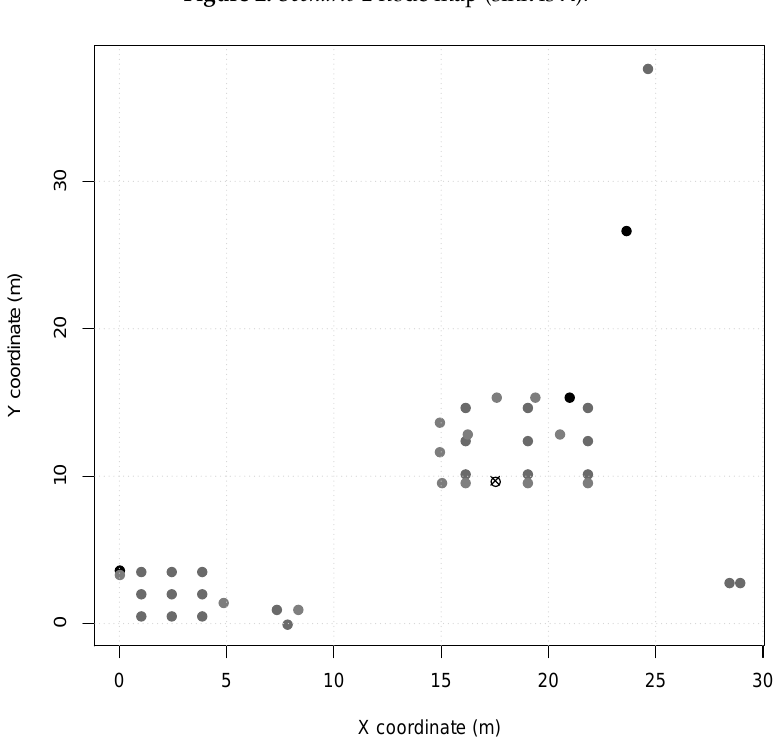
Figure 3. Scenario 3 node map (sink is